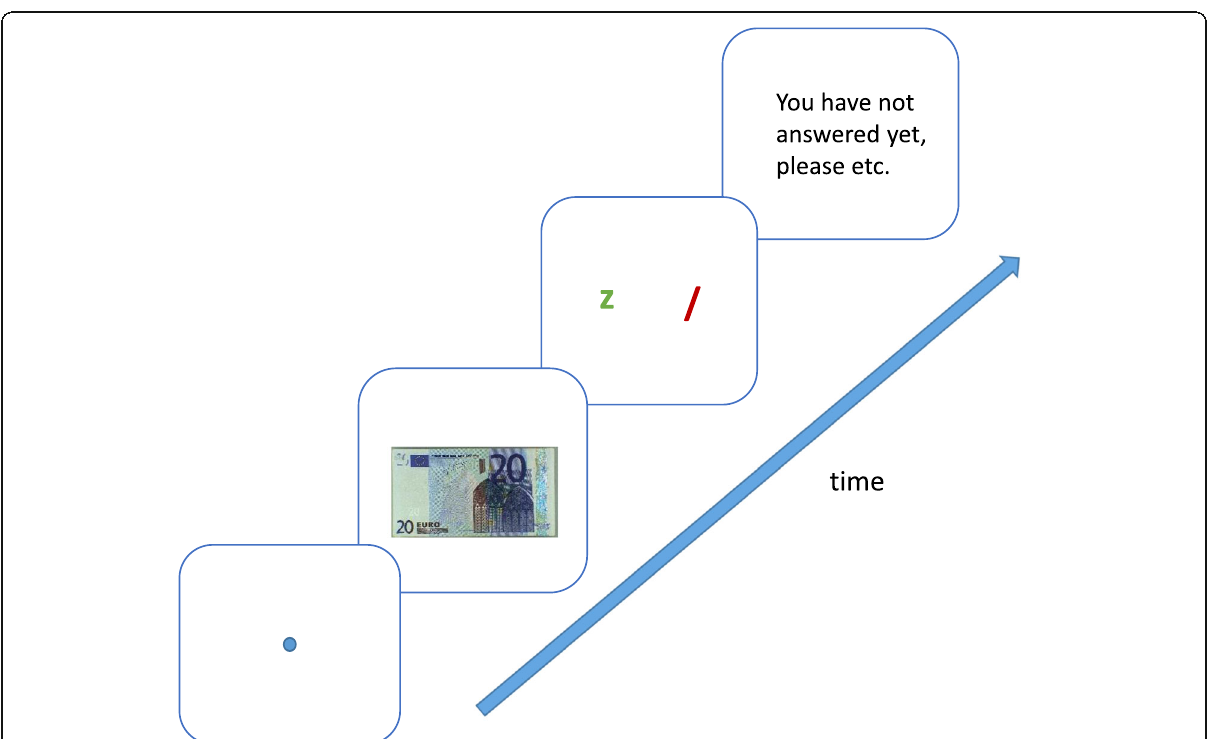
Fig. 4 Procedure screen test. The core structure of the trial. Every trial started with a fixation dot in the center, for 500 ms, followed by a banknote (either EUR 20 or EUR 50, either genuine or counterfeit, either first or second series). The display duration was either 500 ms, 1000 ms or maximum 10 s and varied between blocks. In case of not pressing the right key a reminder was